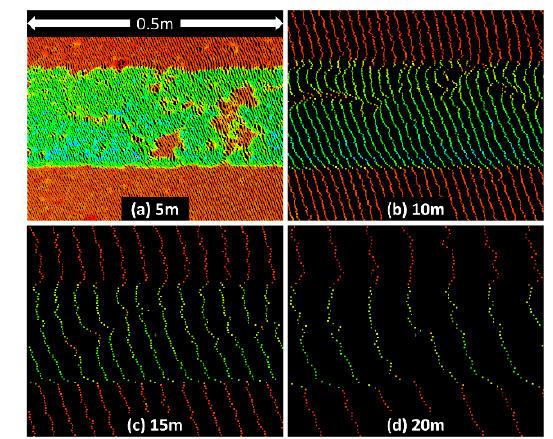
Figure 5. Examples of varying point densities within a point cloud from a single scan at (a) 5 m, (b) 10 m, (c) 15 m, (d) 20 m from the scanner (Note that four different parts of the stripe are shown in this figure at the same scale).